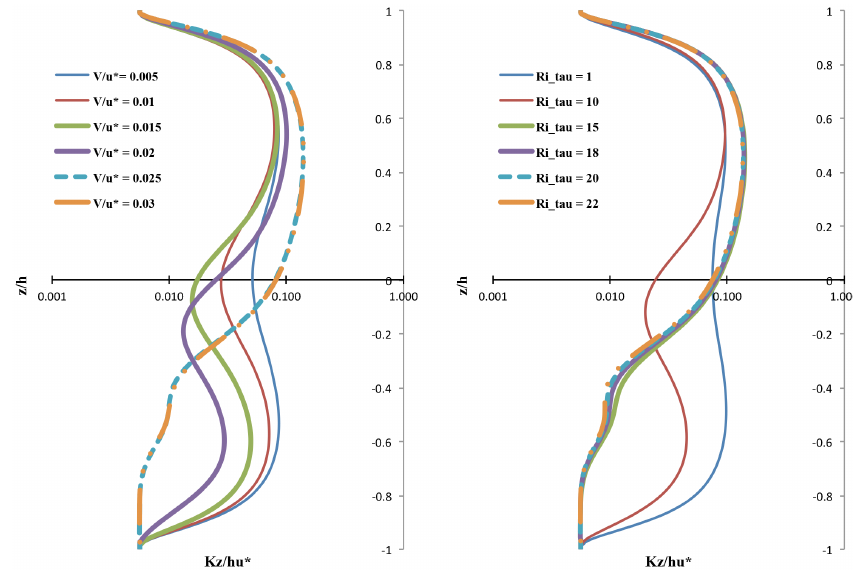
Figure 4. The trend for vertical sediment diffusivity mirrors the trend found for turbulence intensity. An increase in degree of self- stratification is found to decrease sediment diffusivity in the lower half of the channel and increase sediment diffusivity in the upper half of the channel. This is not completely unexpected because mixing of suspended sediment is primarily dependent on turbulence in the flow.